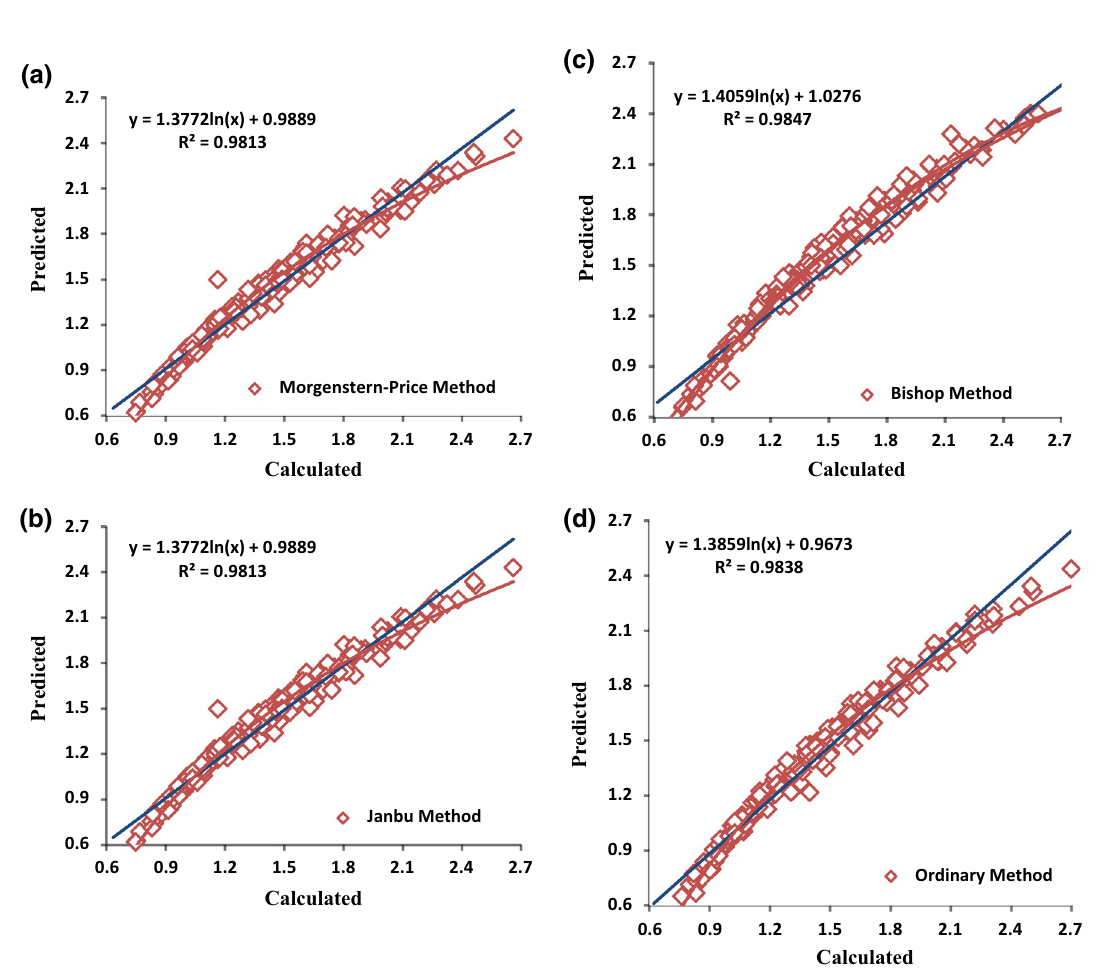
Fig. 9 The safety factor of the numerical and regression method, a Morgenstern–Price method, b Janbu method, c Bishop method and d ordi- nary